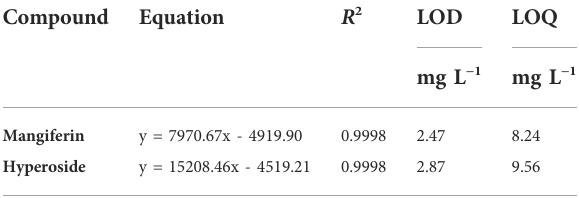
TABLE 1 Calibration curves of mangiferin and hyperoside with HPLC-PDA. Compound